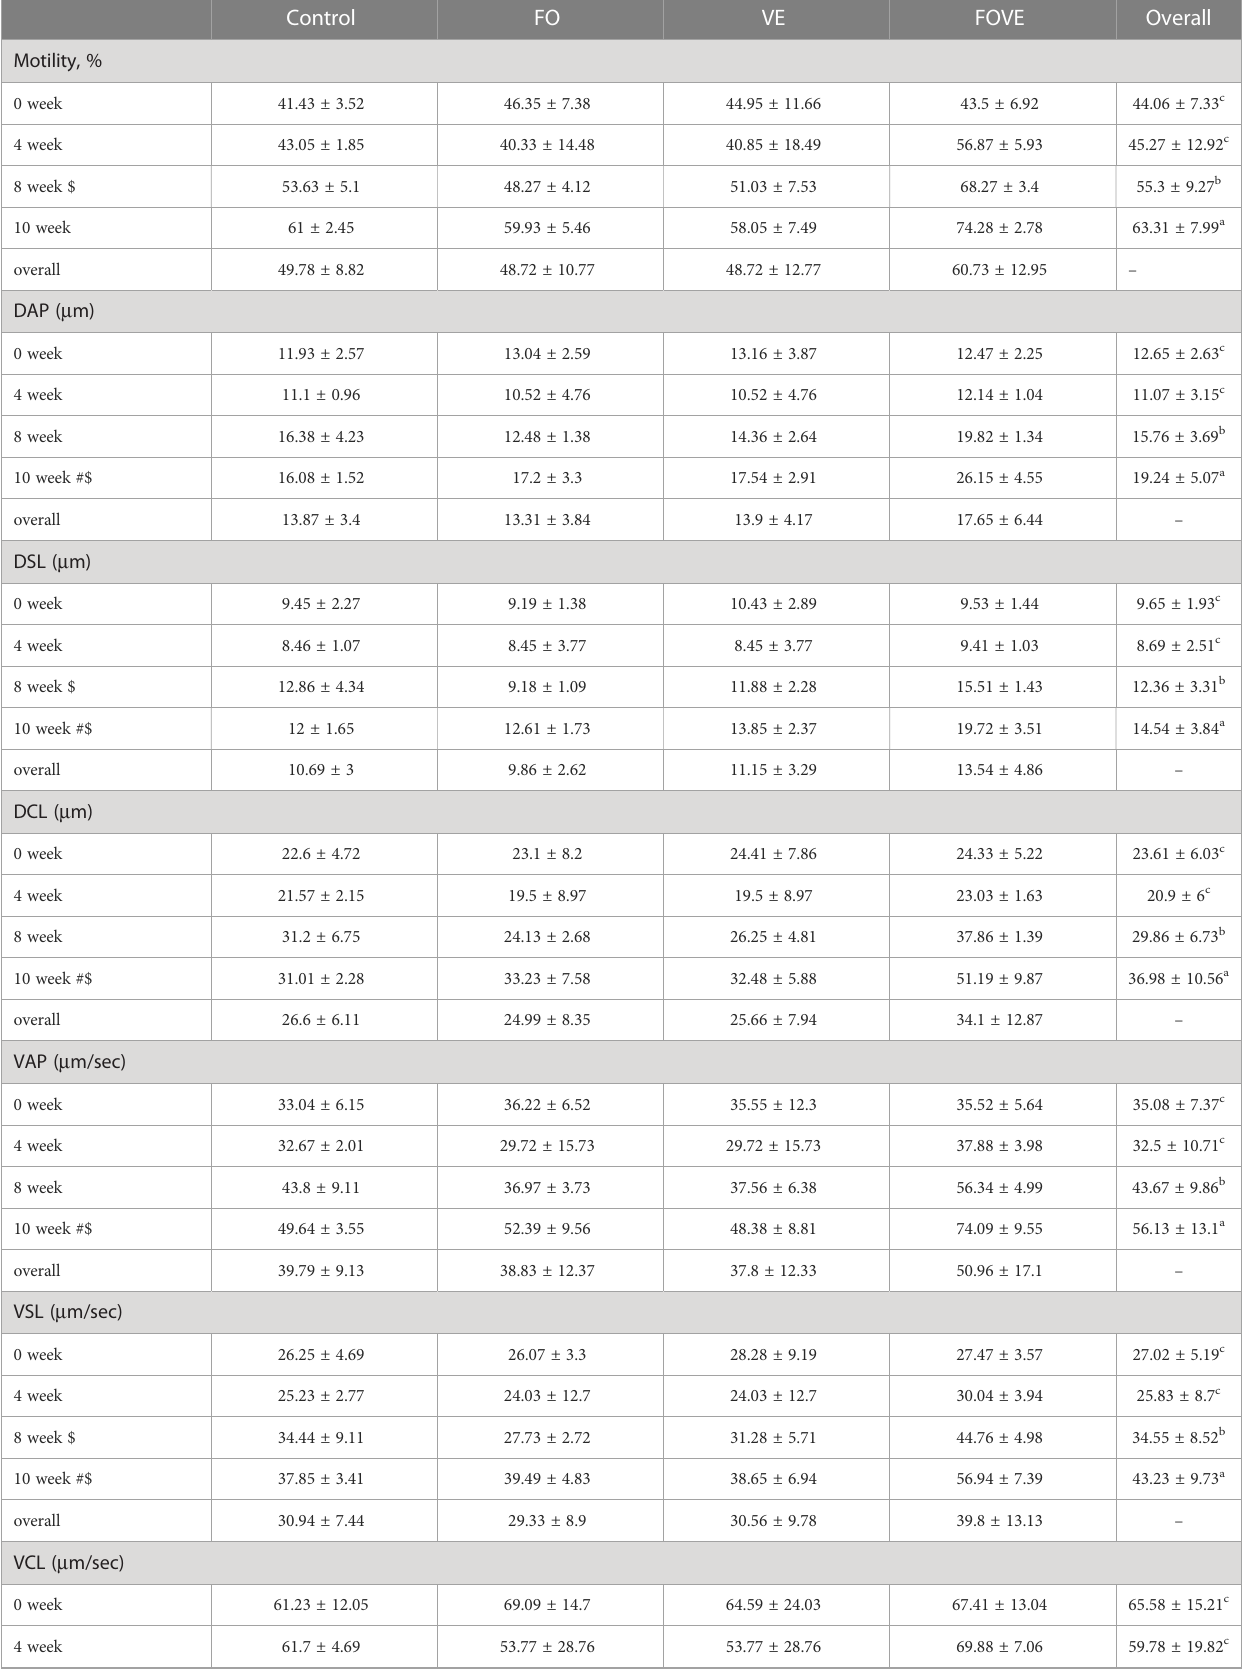
TABLE 3 Frozen-thawed sperm motility and motion parameters. Control FO VE Motility,